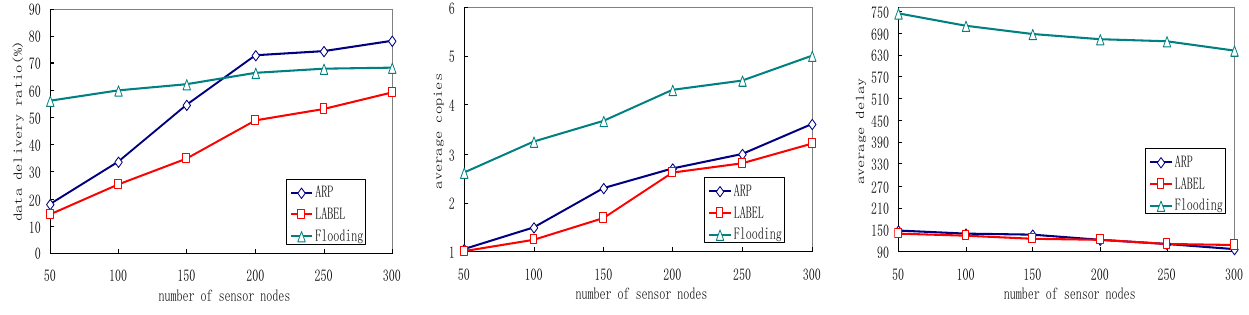
Figure 8. Impact of sensor node density: (a) Average delivery ratio; (b) Average copies; (c) Average